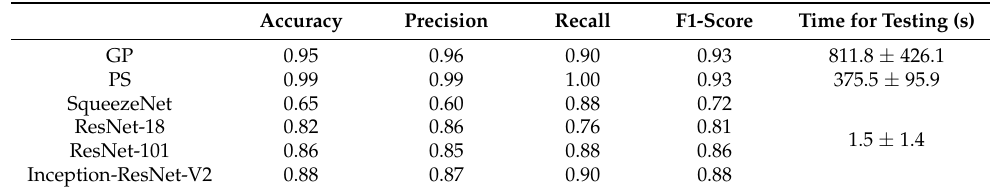
Figure 5. Boxplot of diagnostic performances among three groups. Kruskal–Wallis test was performed to analyze the sta- tistical significance of specificity. GP: General Practitioners, PS: Pediatric Specialists, * p < 0.05; Kruskal–Wallis test.